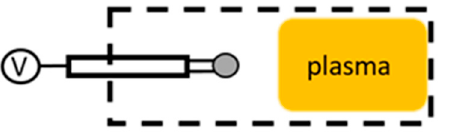
Figure 7. Schematic of a typical calorimetric probe for measuring the O-atom density via the heat dissipated on the surface of the probe, which enables the determination of the recombination coefficient.